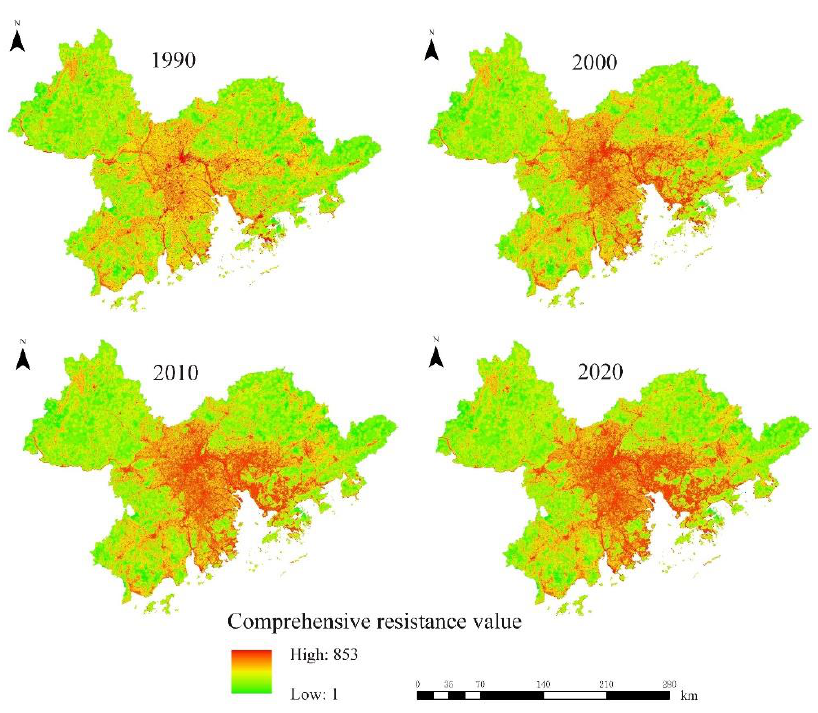
Figure 3. The final comprehensive resistance value from 1990 to 2020.